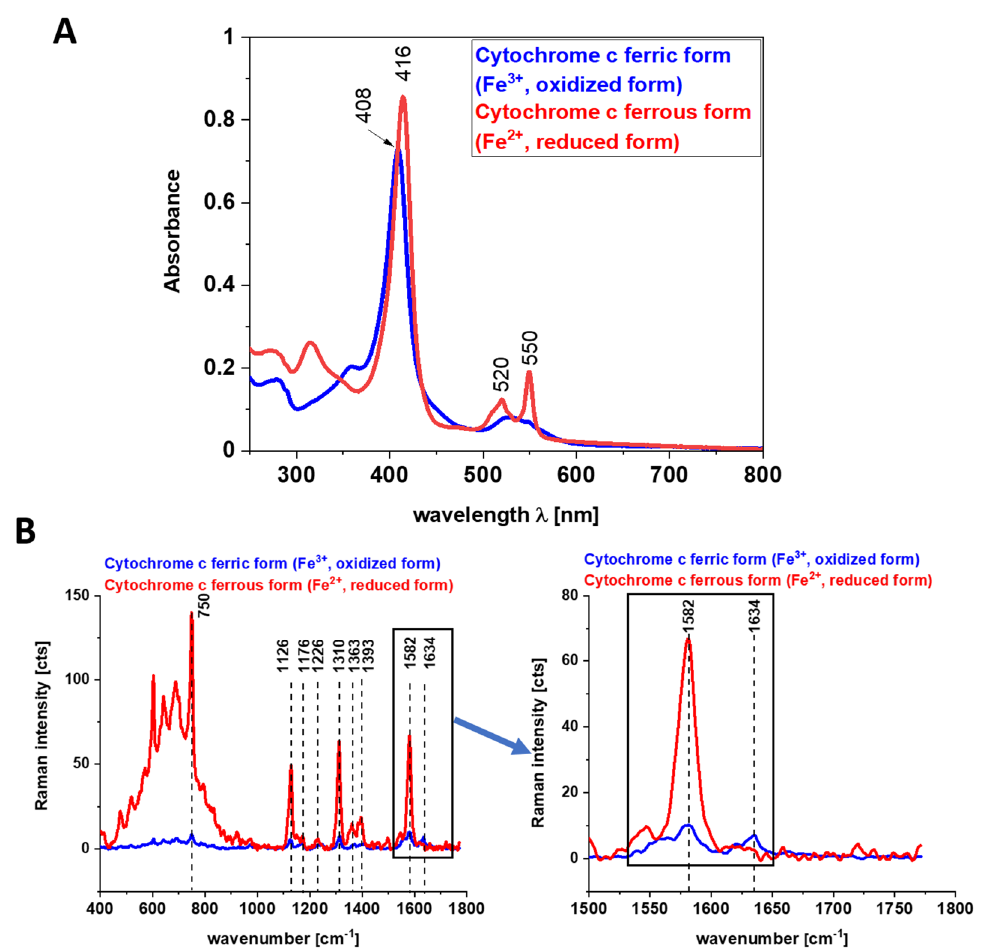
Figure 5. Electronic absorption spectra ( A ) and Raman spectra ( B ) of cytochrome c in ferric (oxidized, Fe 3+ ) and ferrous (reduced, Fe 2+ ) states in phosphate buffer pH = 7.3, cuvette optical path 1 cm. Ferrous cytochrome c was prepared by adding 10-fold excess NaBH 4 (as a reductor).